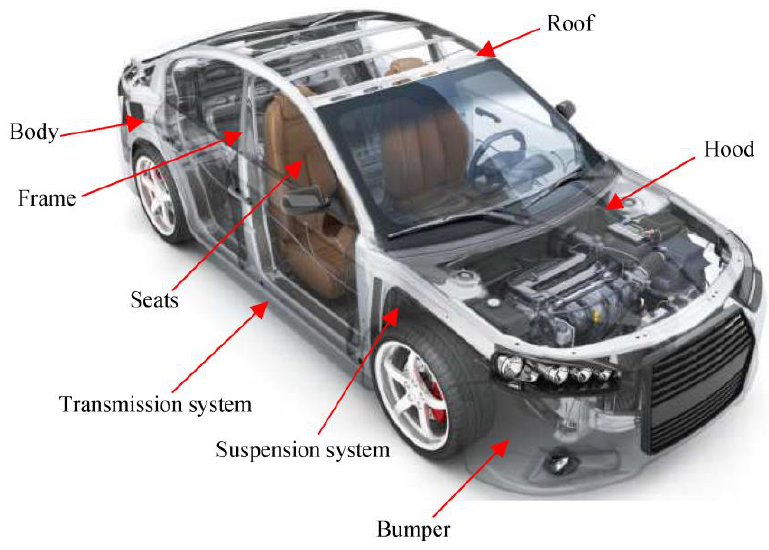
Figure 16. Automotive parts can be replaced with composites (adapted with permission from Ref. [59]).